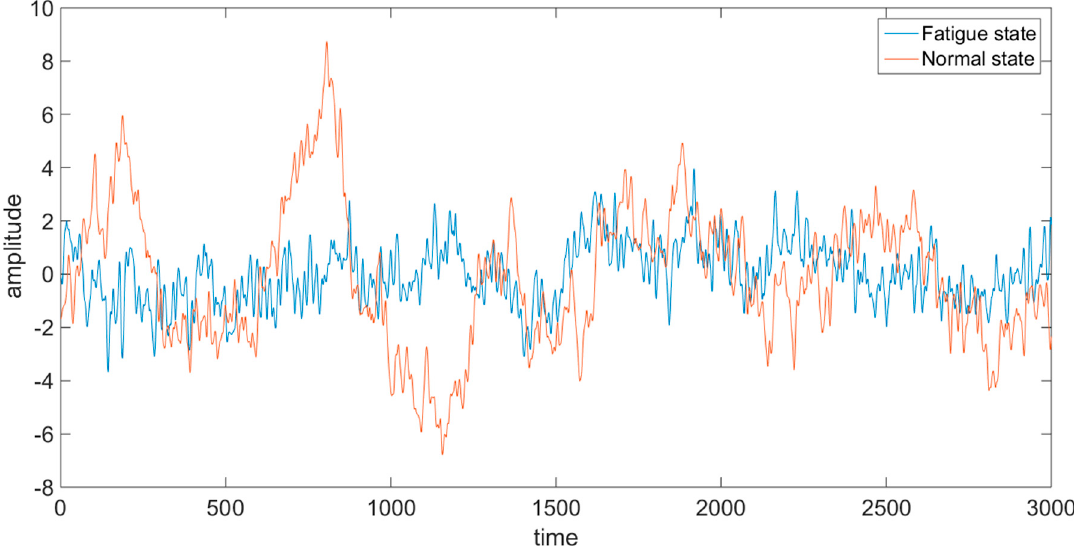
Figure 2. Comparison between EEG signals in normal state and fatigue state in the time domain.